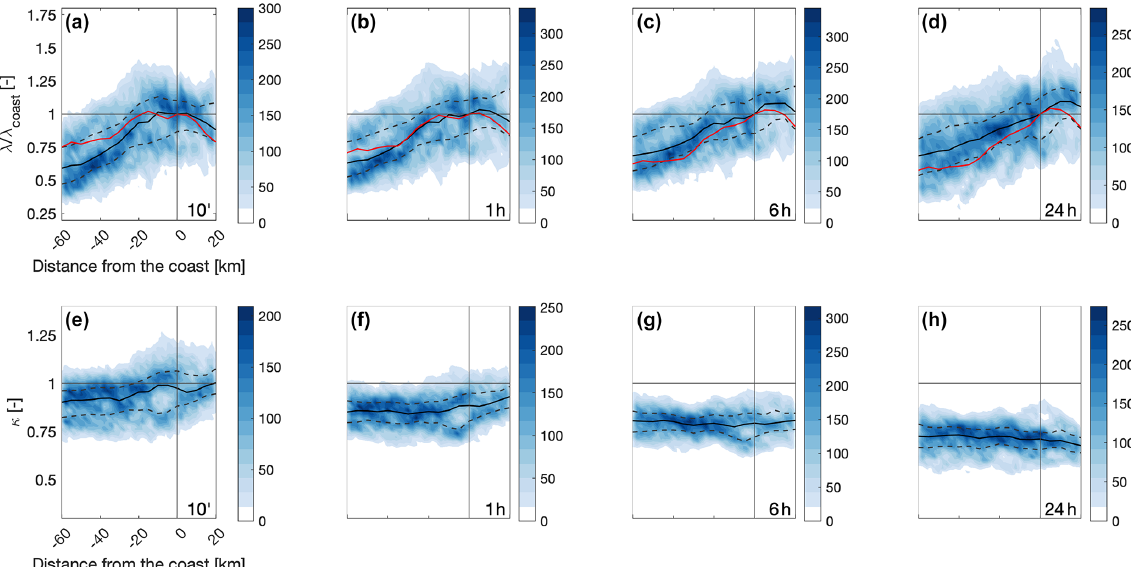
Figure 3. Density plots of the scale (a–d) and shape parameters (e–h) as a function of the distance from the coastline (see dashed lines in Fig. 1) for durations of 10min and 1, 6, and 24h. Color shading represents the number of radar pixels in bins of 2km by 0.05 (a–d) and 2km by 0.01 (e–h) . Negative distances represent offshore areas. The median and 25th–75th quantiles of the distribution along 5km bins are shown as solid black lines and dashed black lines, respectively. In order to have comparable values across durations, scale parameters (a–d) are normalized over the median value at the coast. For comparison, solid red lines show the median of the normalized maximum intensities (which can be considered as a proxy for the scale parameter) from convection-permitting Weather Research and Forecasting (WRF) model simulations of 41 heavy precipitation events in the region (details in Armon et al., 2020). This confirms that the decrease offshore is a climatic signal and not an artifact due to distance from the radar and lack of rain gauges for the adjustment (see Sect. 5).